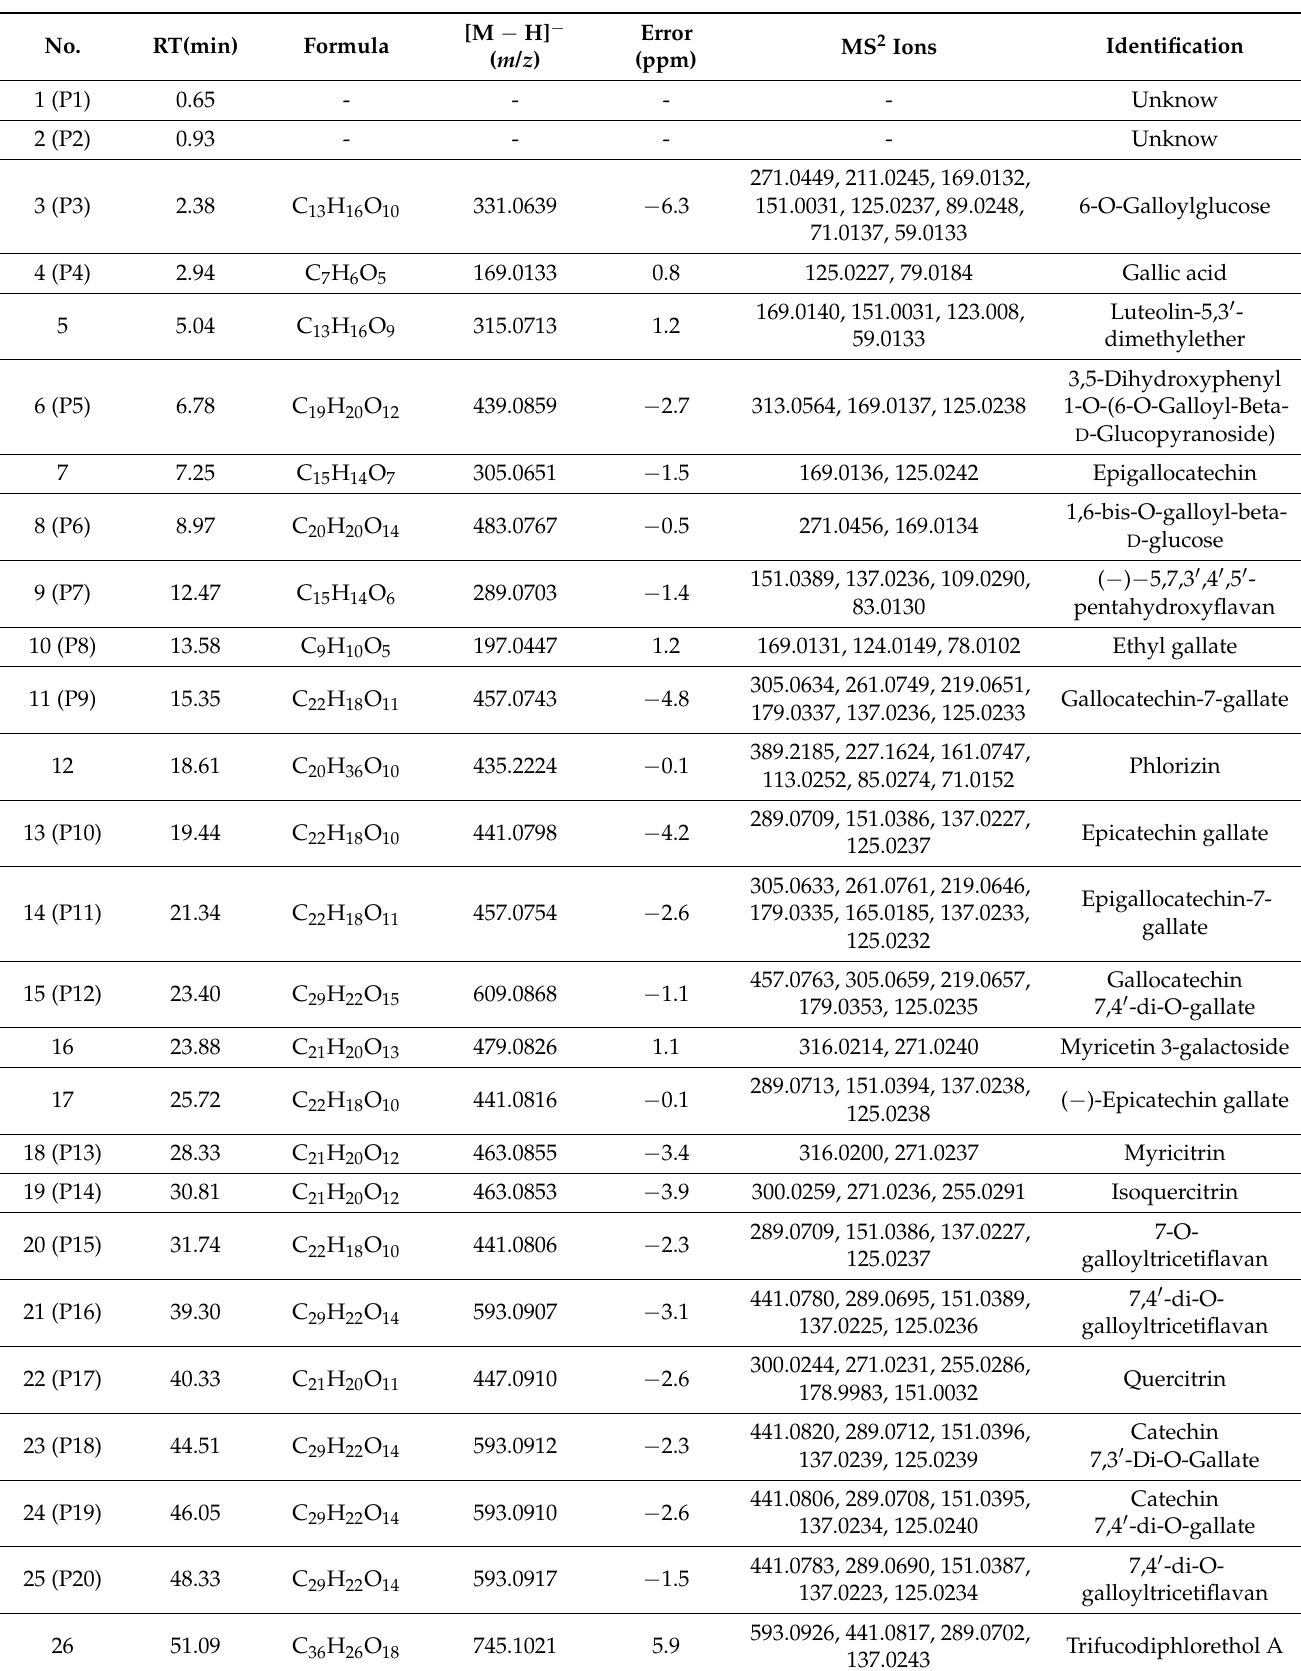
Table 1. Identification of A. clypearia